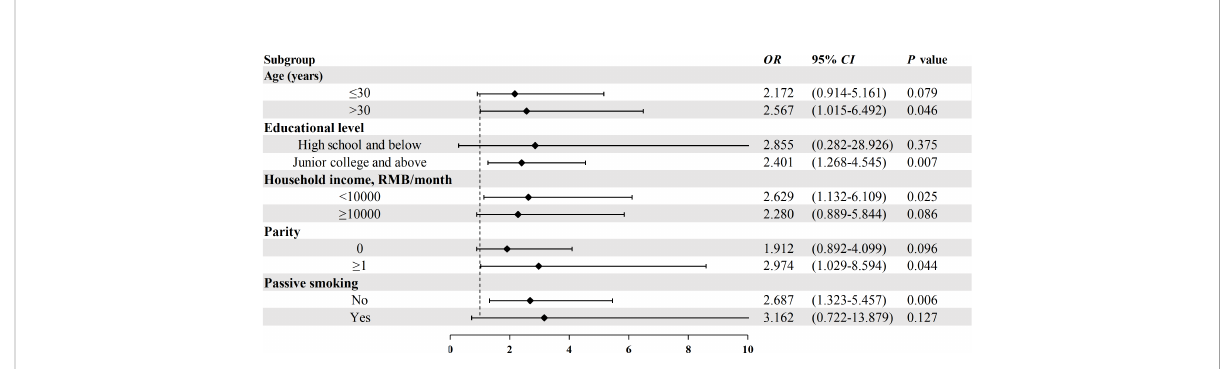
FIGURE 1 Strati fi ed analysis on the association between serum MC-LR and the risk of GDM. Model adjusted for age, pre-pregnancy BMI, weight gain during pregnancy, education level, occupation, household income, family history of diabetes, parity, and passive